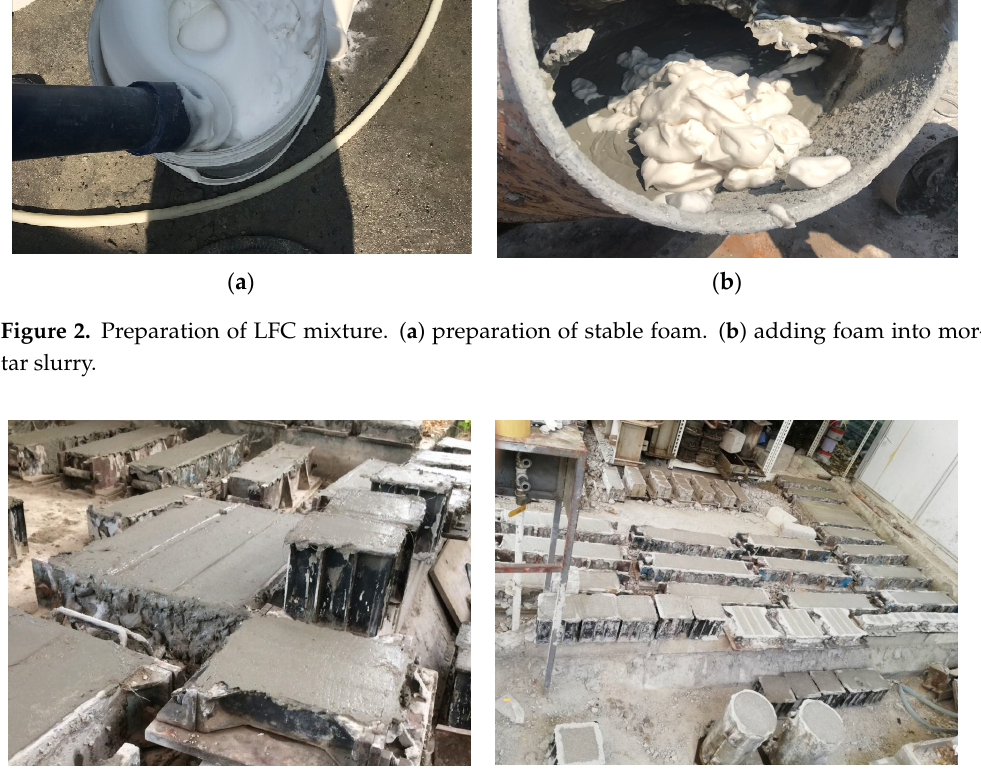
Figure 3. LFC slurry was then poured into molds.